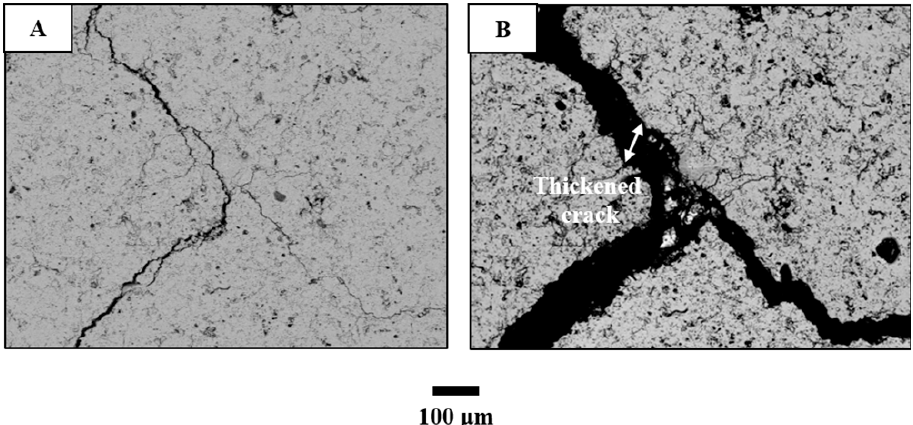
Figure 5. Surface crack thickening during CTF tests: ( A ) as-prepared crack and ( B ) thickened crack after 320 cycles.